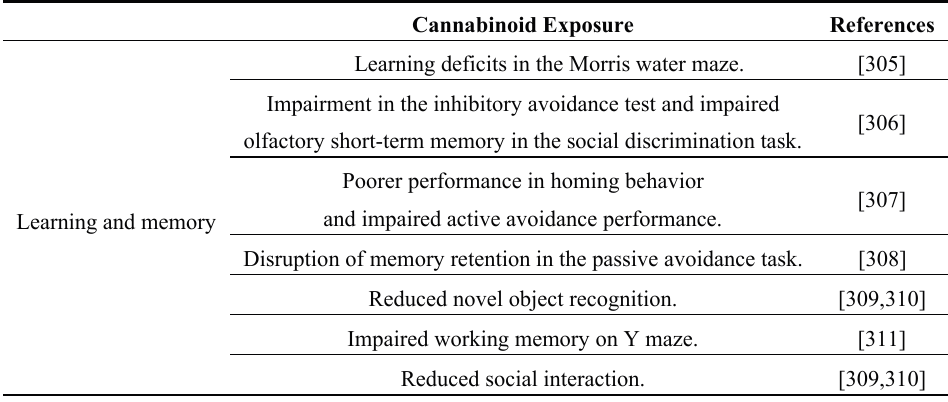
Table 2. Summary of Long-lasting behavioral abnormalities found in animals as consequences of cannabinoid exposure and CB1 receptor activation during brain